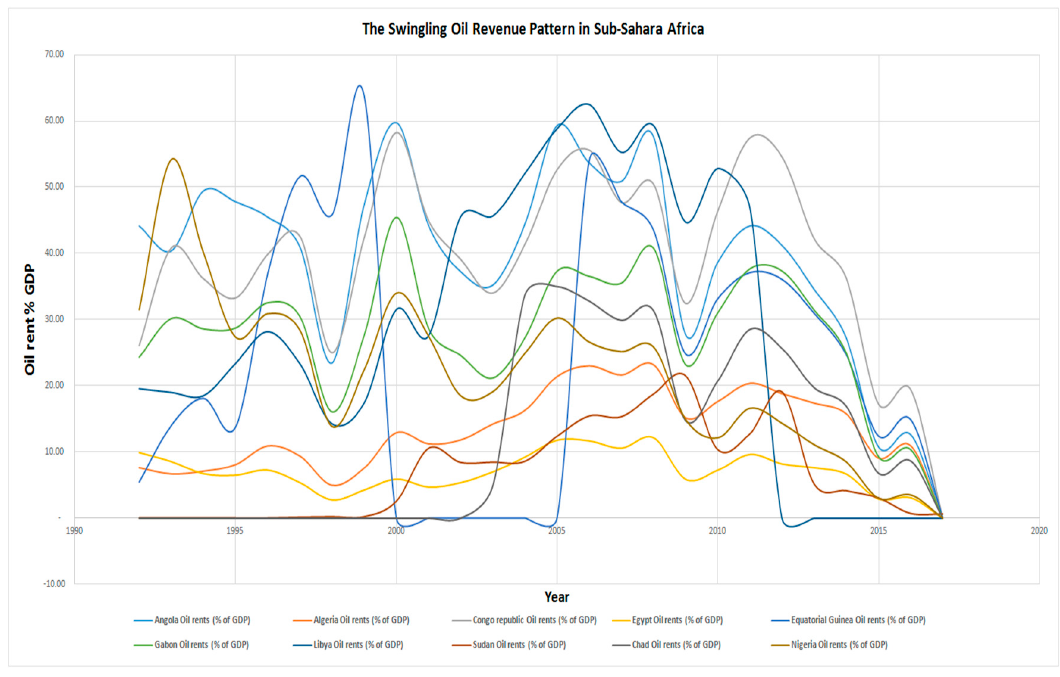
Figure 3. Oil rent in top ten crude oil-producing African countries. Source: World Bank data group.